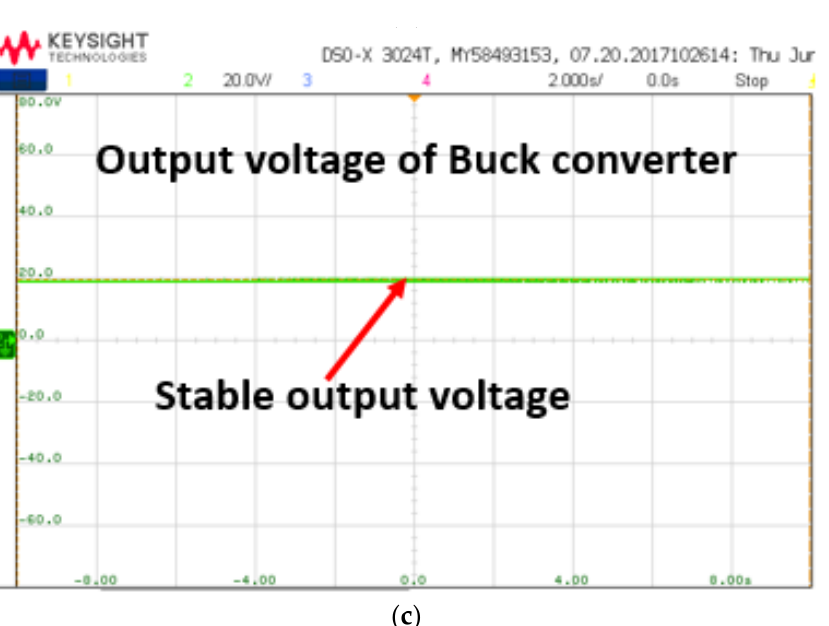
Figure 11. Experimental investigation. ( a ) A prototype of DC microgrid setup; ( b ) output voltage of boost converter; ( c ) output voltage of buck converter.